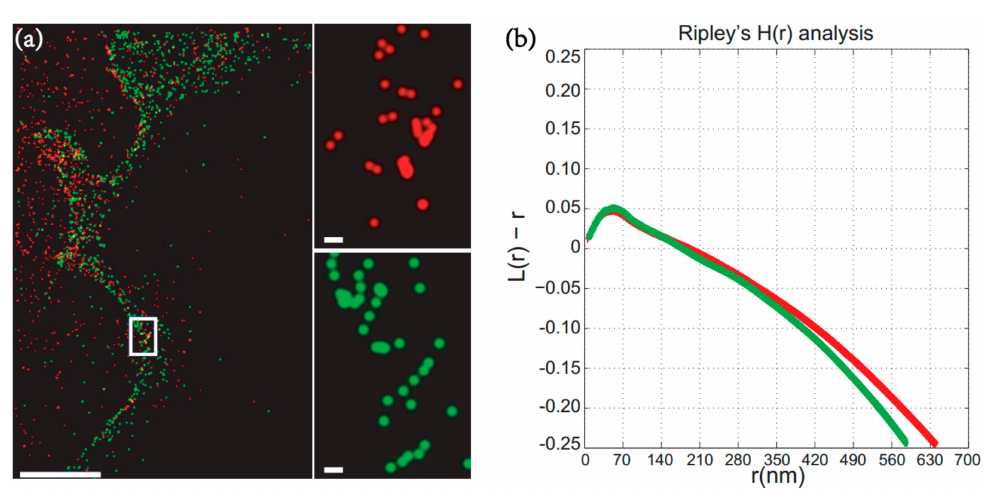
Figure 5. ( a ) The EGFR distributions at fibroblast-like cell lines derived from monkey kidney tissue - COS7 membrane surface observed by universal point accumulation imaging in nanoscale topography (uPAINT)method (left), scale bar 5 µ m. Zoomed region (right), scale bar 200 nm. ( b ) Ripley’s H plot showing peak clustering scales at 50 nm for both colors and clustering above the level expected for a random distribution on the length scales up to ~180 nm.